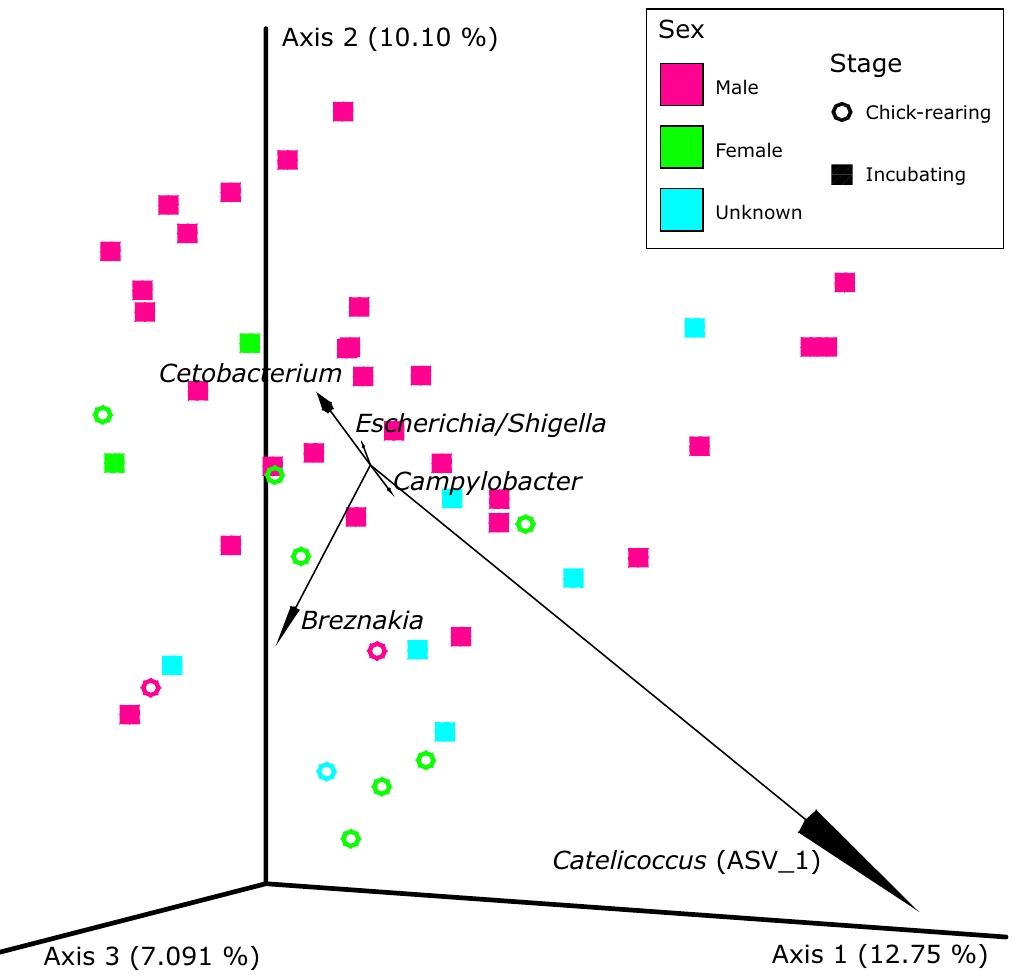
Figure 2. Principal Coordinates Analysis (PCoA) plot for the gut community composition using the unweighted UniFrac metric with samples identified by sex and reproductive stage. Biplots show the taxonomy of the ASVs with the top 5 effects on the community composition with position of the arrow indicating the direction of the effect.